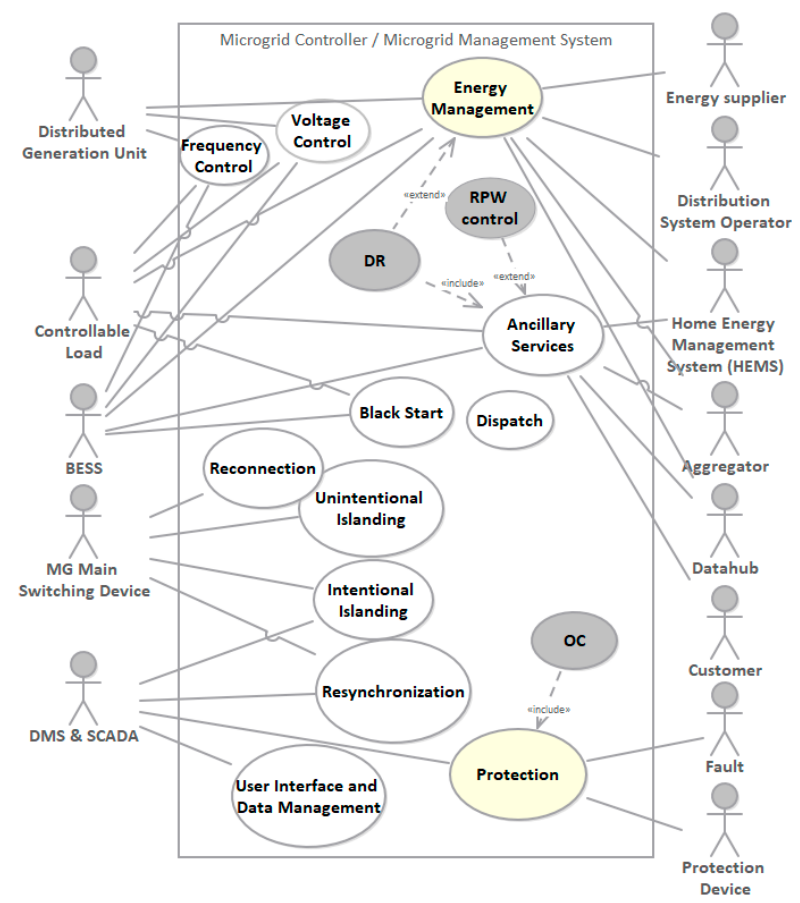
Figure 6. The high-level use cases of a microgrid management system.